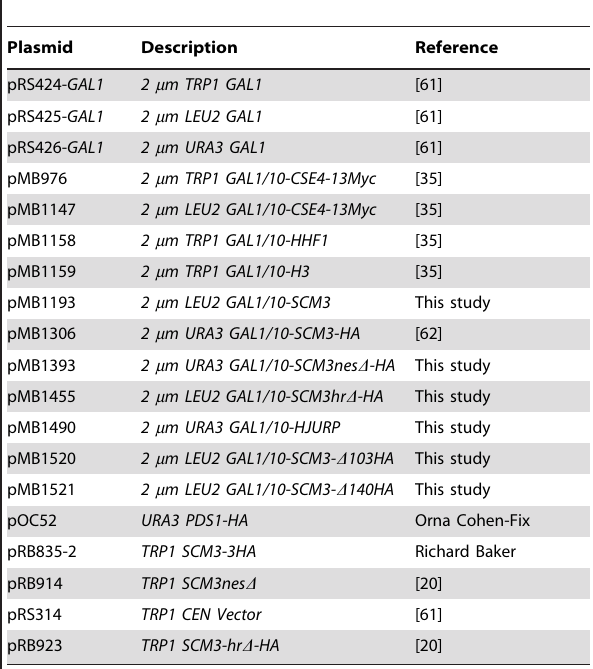
Table 2. List of plasmids used in this study.